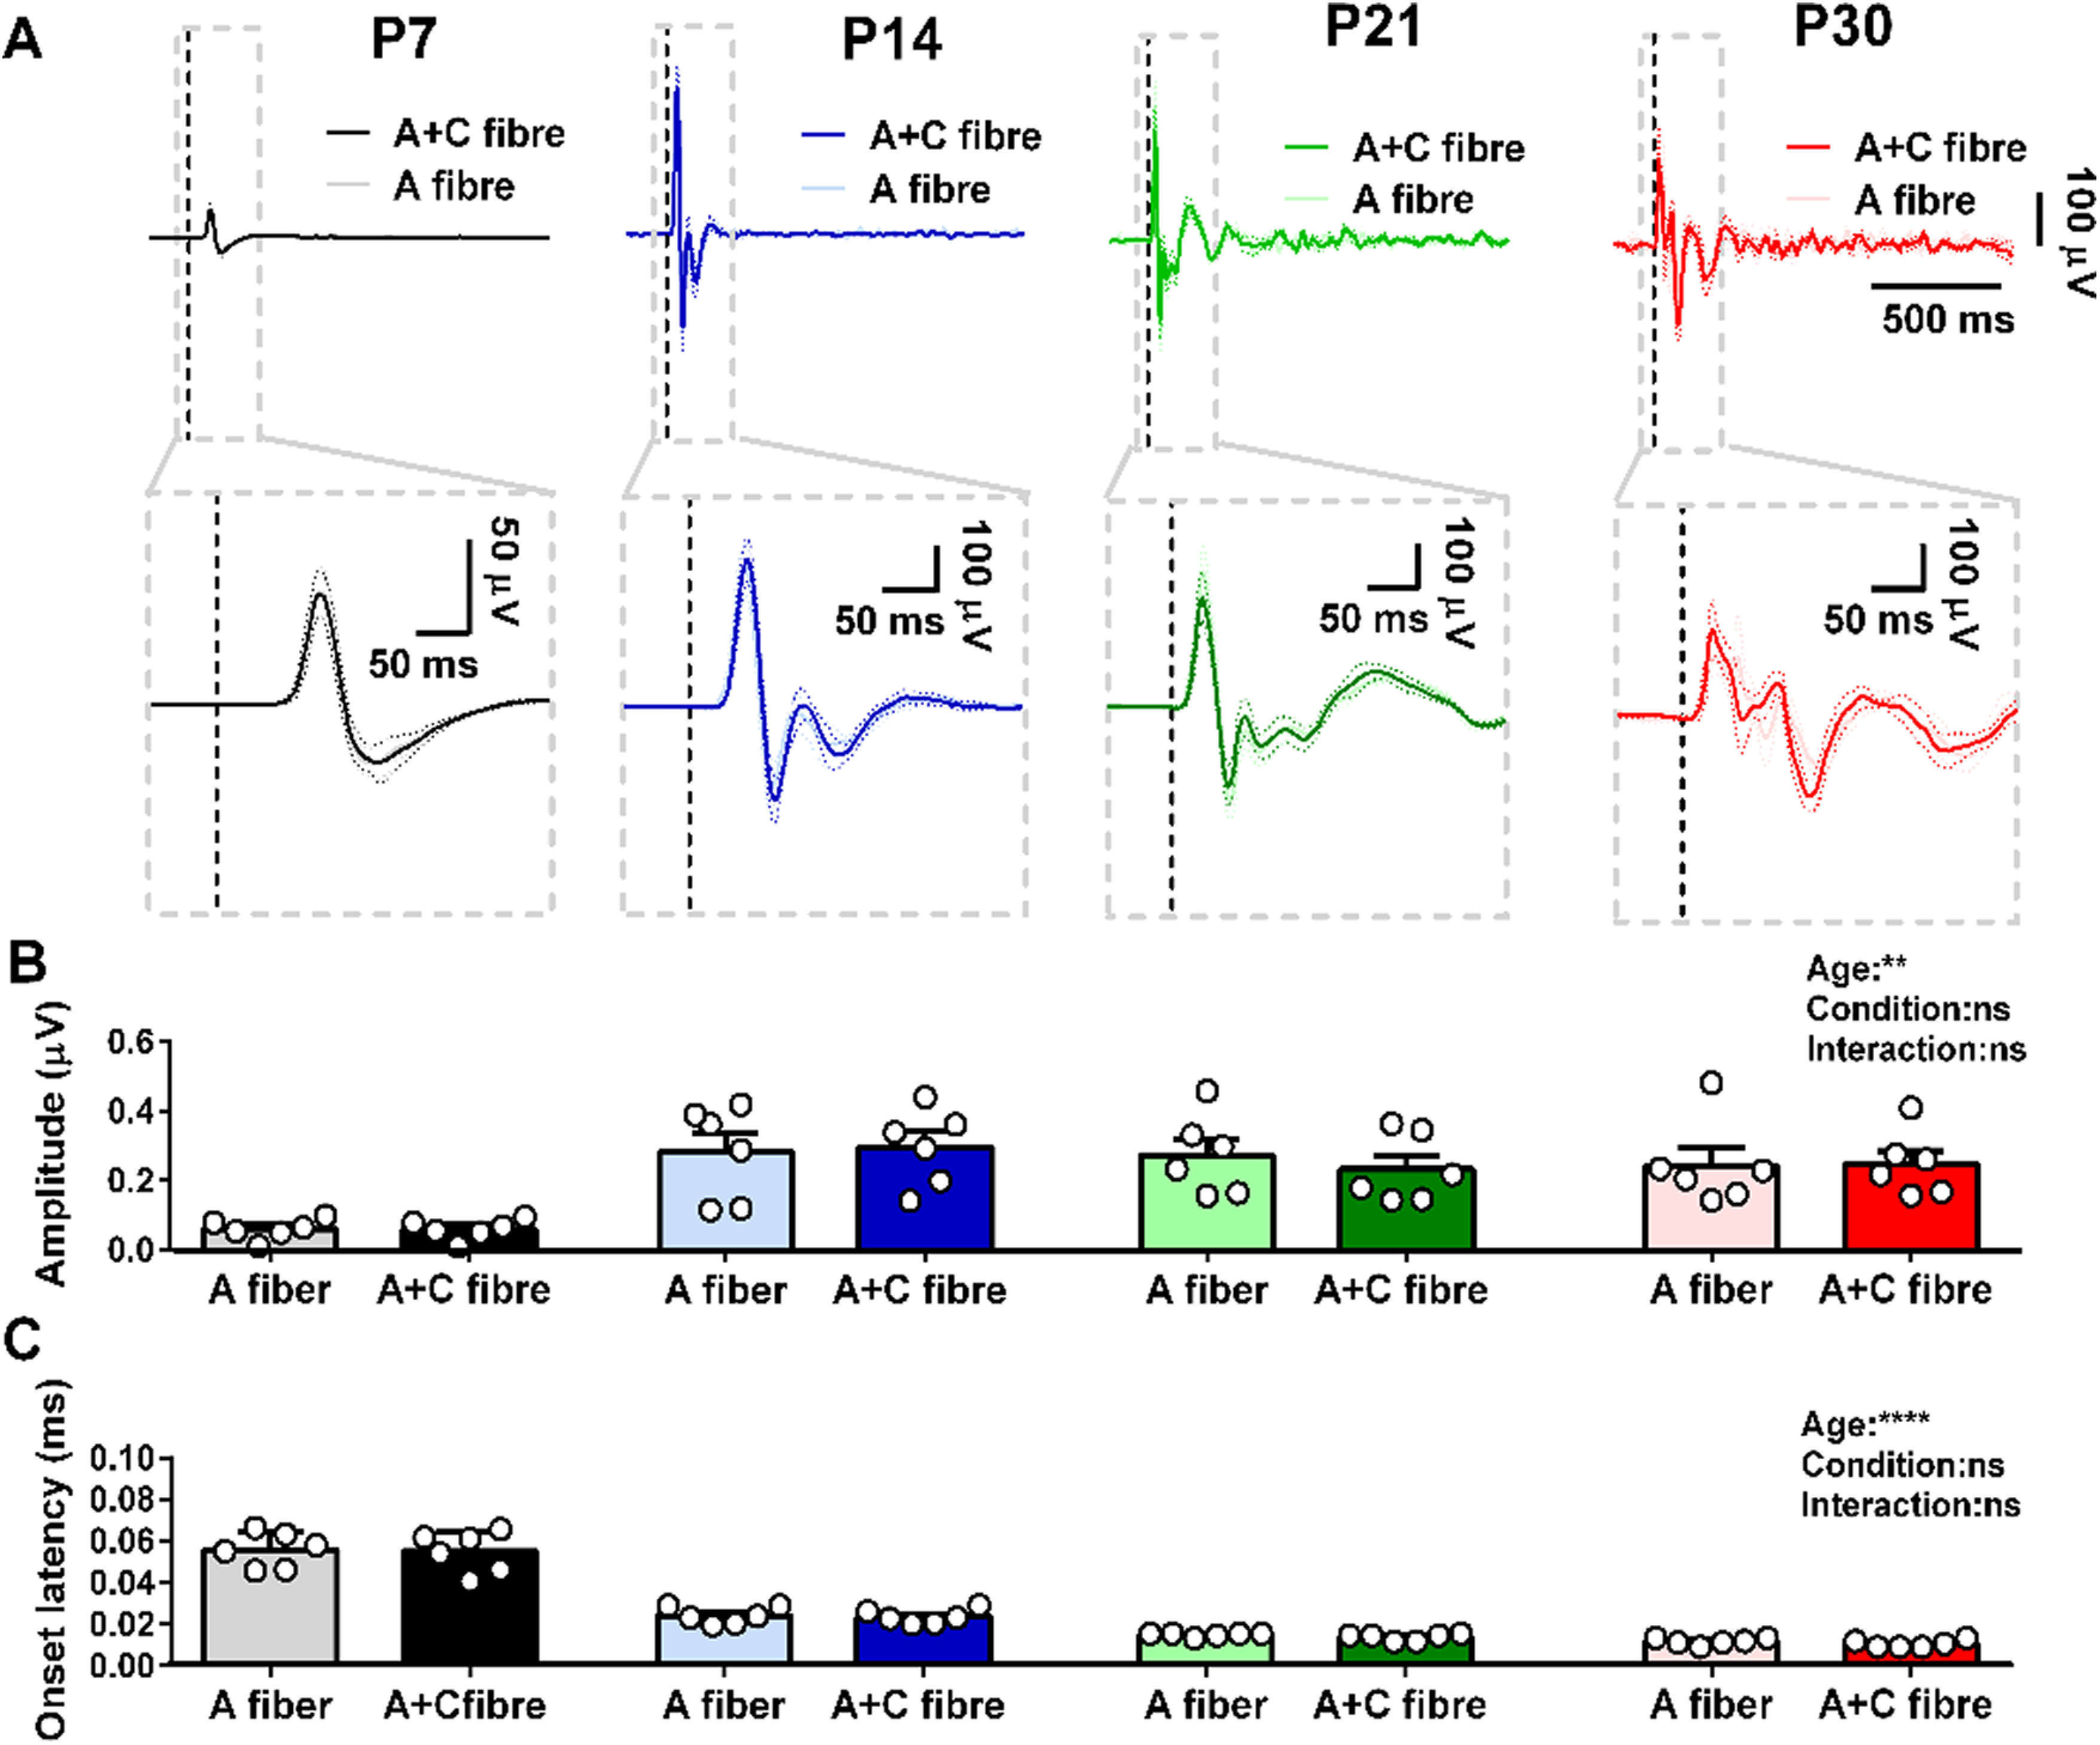
Maturation of evoked local field potentials (EPs) in S1 following contralateral hindpaw stimulation. A, Average EPs following A fiber (50 μs) and A + C fiber (500 μs) electrical stimulation of the contralateral hindpaw at postnatal day (P)7, P14, P21, and P30 (mean ± SEM, 10 stimuli at 10-s ISI, 3.2 mA, n = 6 rats at each age). Lower panels are a zoom-in view of the gray boxes in the top panels. Vertical dotted lines indicate the time of stimulation. EP peak amplitude (B) and onset latency (C) in response to electrical skin stimulation; two-way mixed ANOVA; **p < 0.01, ****p < 0.0001, and ns: not significant. Data are shown as means ± SEM. Each dot represents average of stimuli from one animal.